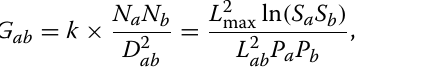
Table 1 Grading values and weights of resistance factors for the construction of an ecological resistance surface Resistance factor Classification index